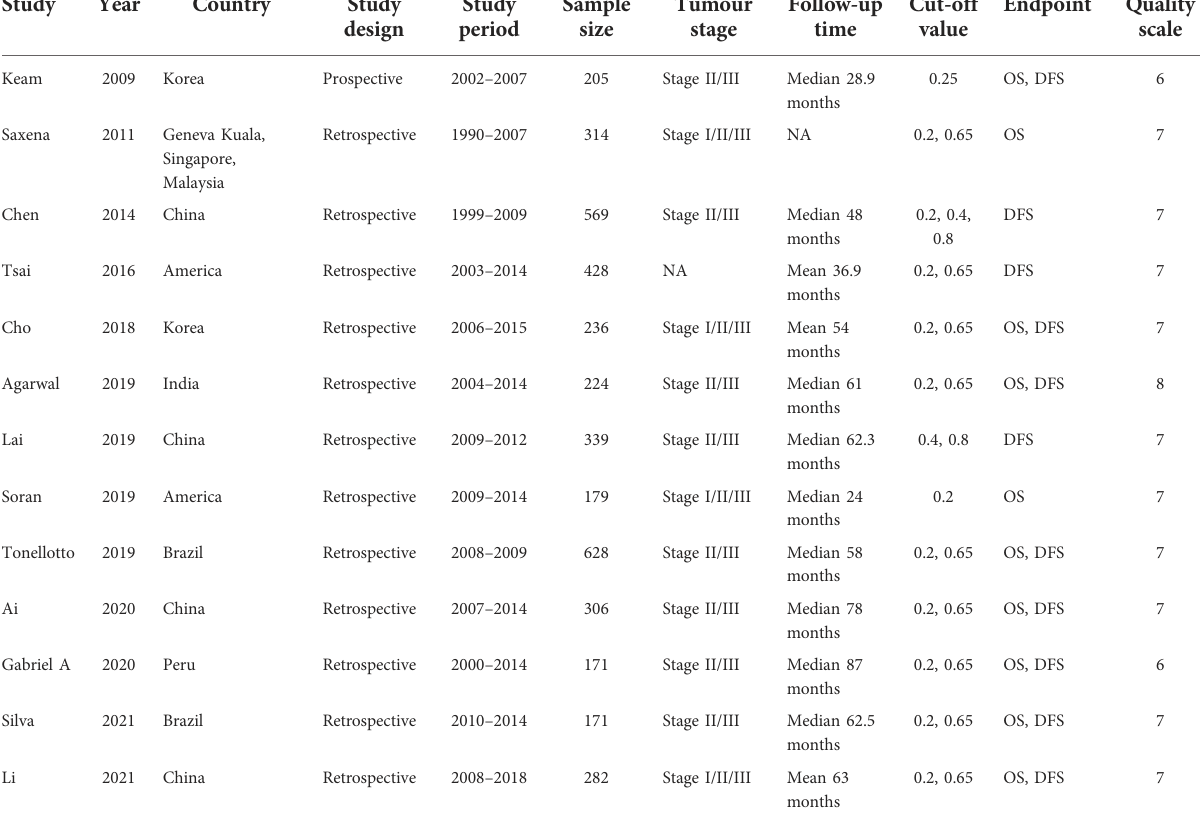
TABLE 1 Characteristic of the included